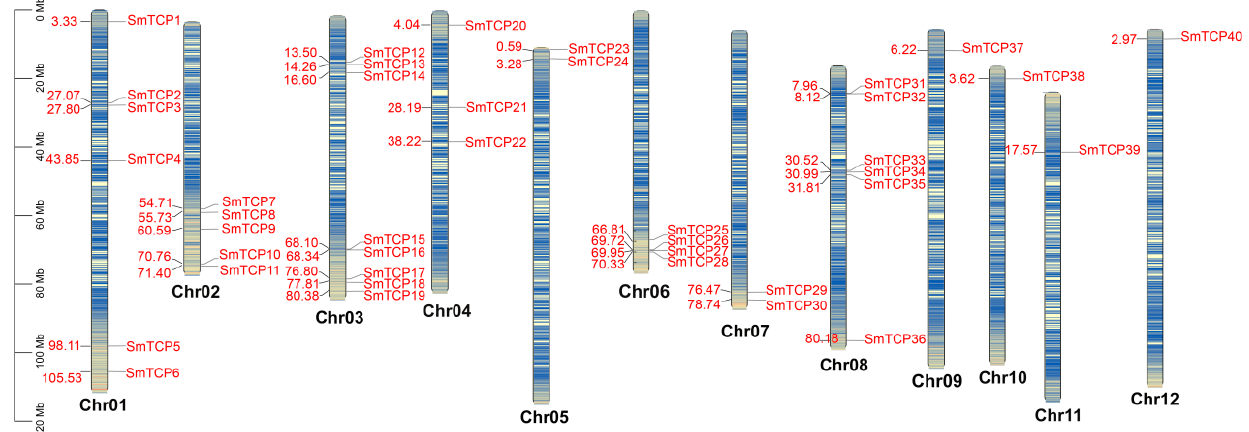
Figure 1. Chromosome density and chromosomal locations of the SmTCPs genes. Note: Chr01-Chr12 indicates 12 chromosomes . Scale bar on the left indicates the chromosome lengths (Mb).